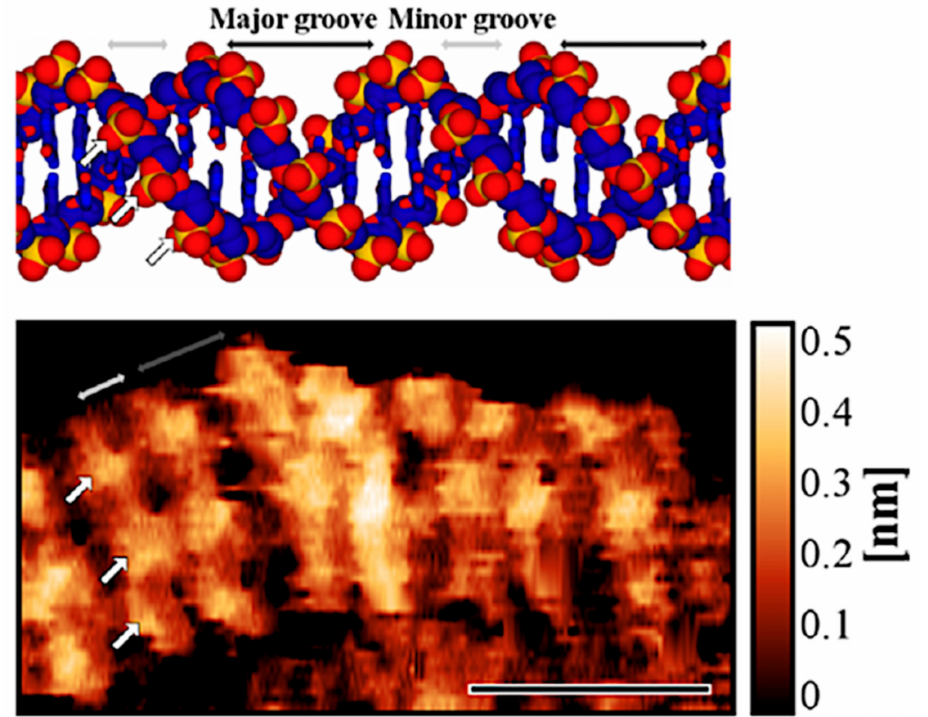
Figure 5. ( Upper panel ) A model of DNA in a B-conformation; ( Lower panel ) Ultrahigh-resolution AFM image of the DNA molecule obtained in FM-AFM mode. White and gray arrows on DNA model and topography are indicating the major grove, minor groove, and phosphate groups of the DNA backbone. Scale bar: 5 nm. The images are reproduced with permission from Kuchuk, K.; Nano Lett. ; published by ACS Publications,